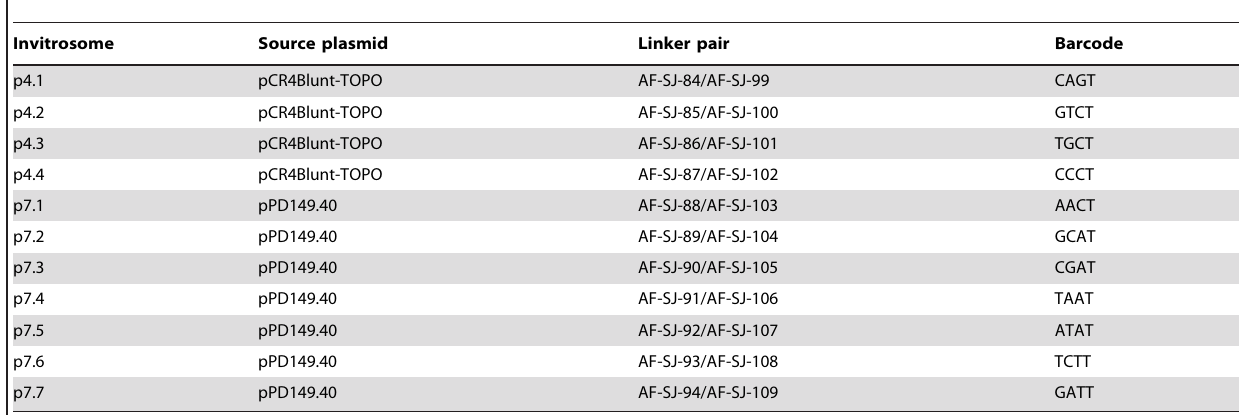
Table 1. Plasmids, Backbones, Primers and